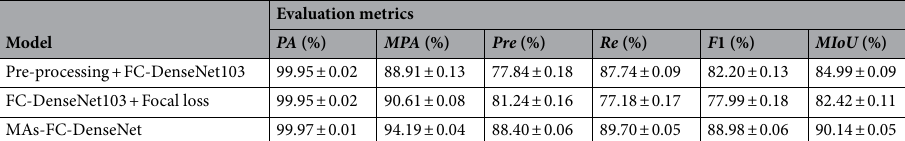
Table 1. Comparison of MA detection performance in ablation